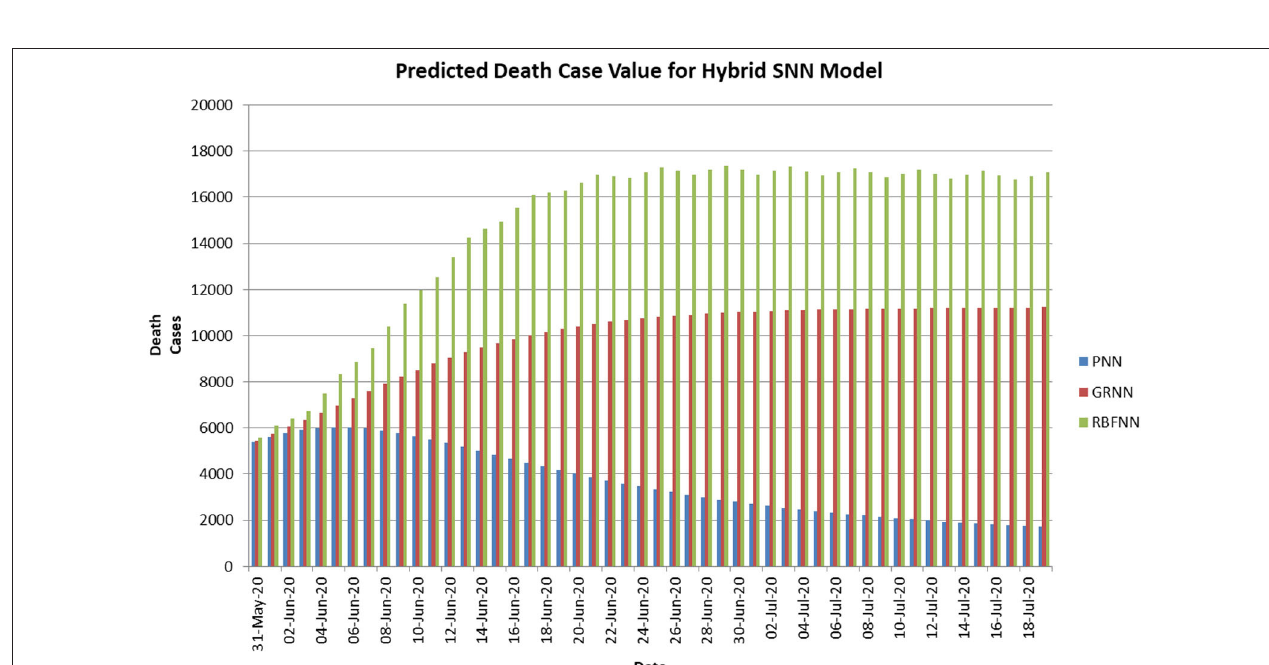
FIGURE 5 | Predicted curve for hybrid